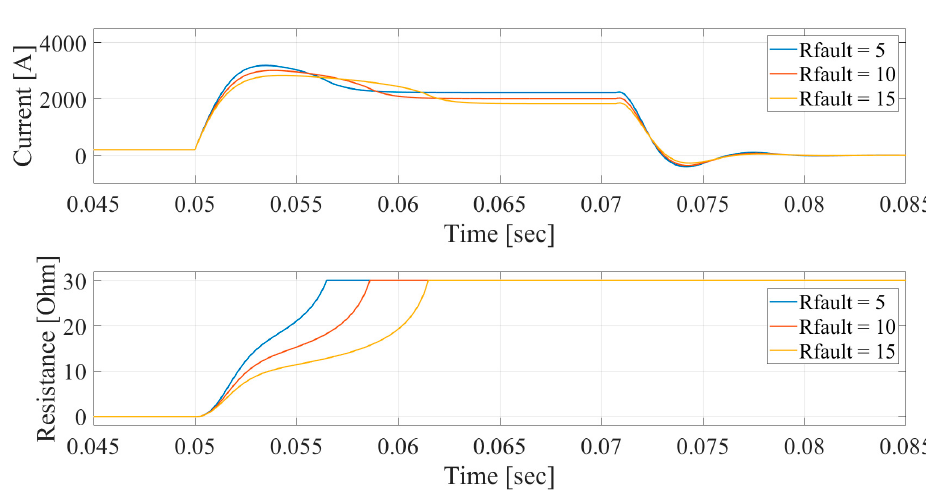
Figure 11. Influence of fault resistance in transition time of magneto-thermal model.